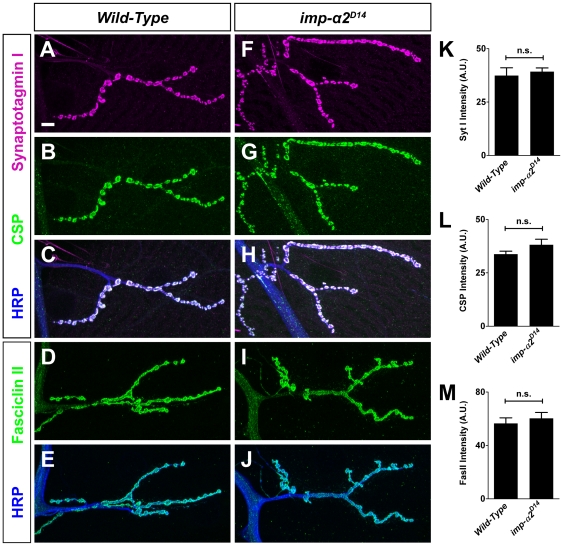
Common Synaptic Markers are Normal in importin-α2 Mutants.(A–E) Representative confocal projections of the larval NMJ at muscle 4 stained with antibodies to Synaptotagmin I, Cysteine String Protein (CSP), Fasciclin II, and HRP, as indicated, in wild-type (y,w; FRT42D; +; +) larvae. (F–J) Representative confocal projections of importin-α2 mutant larvae (y,w; imp-α2D14; +; +) stained as in (A–E). As in wild-type larvae, synaptic vesicle proteins and Fas II properly localize at the NMJ in importin-α2 mutants. Scale bar = 10 µm. (K–M) Quantification of the intensity of immunoreactivity for Syt I (K), CSP (L) and Fas II (M) in wild-type and importin-α2 mutant larvae. No statistically significant differences were observed. In all cases, p>0.4, n = 6 animals, 12 NMJs and the error bars indicate S.E.M.